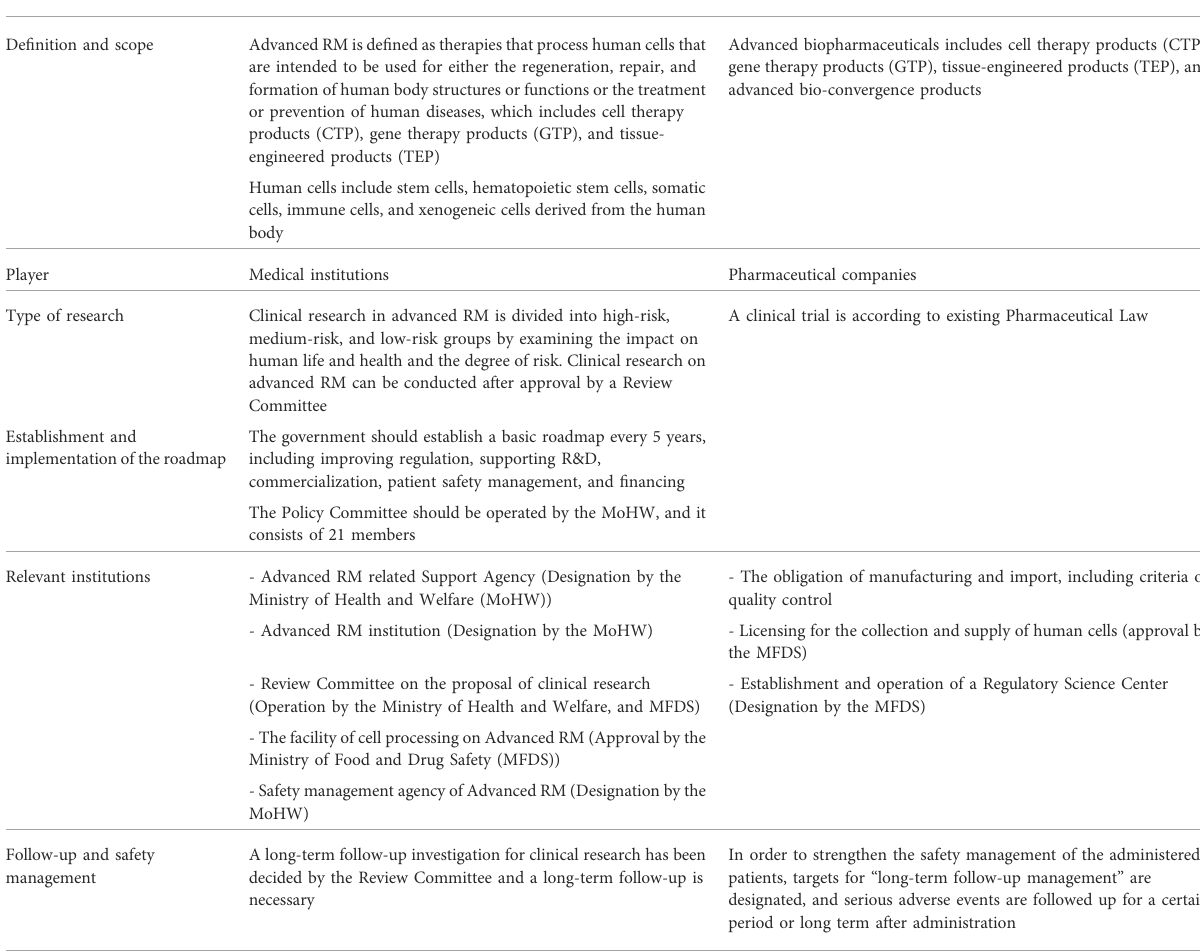
TABLE3KeyelementsofARMABAct:De fi nition,thecriteriaofthefacility(MFDS,2020a;MinistryofHealthandWelfare,2020a;MinistryofHealthand Welfare, 2020b; Ministry of Health and Welfare, 2020c; Ministry of Health and Welfare,